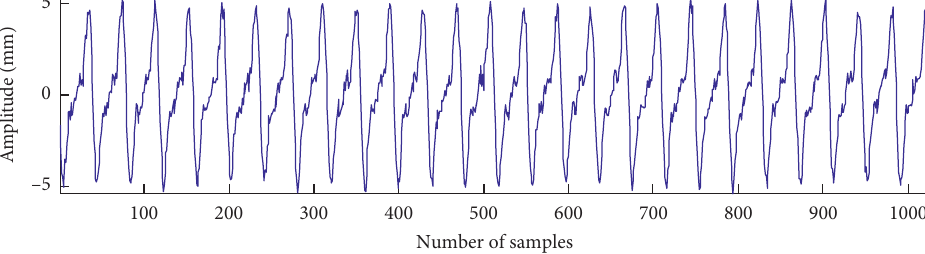
Figure 3: The signal processed by the wavelet and median filter.